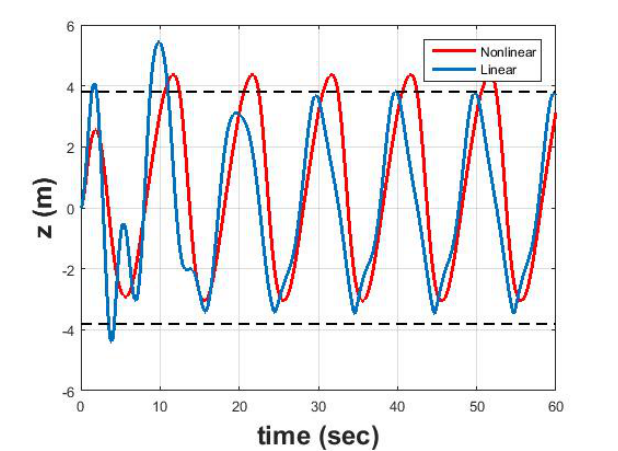
Figure 10. Comparison between the linear and nonlinear WECs in a regular wave: buoy